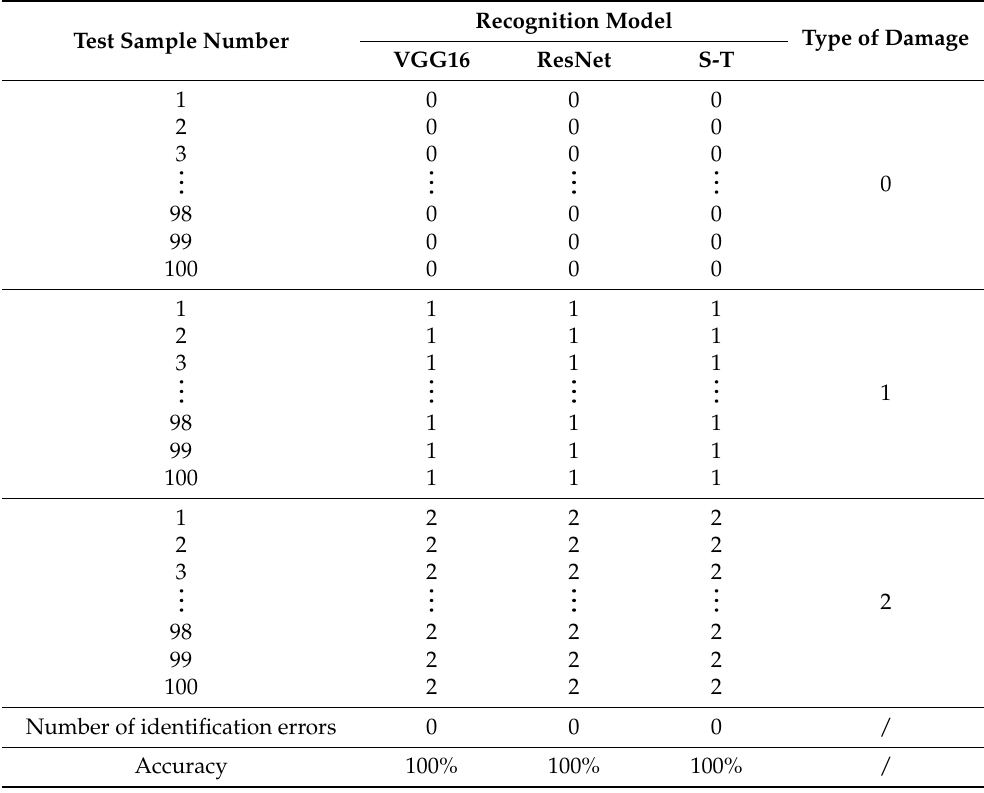
Table 6. The state recognition results of bearing test set for different neural networks. Recognition Test Sample Number